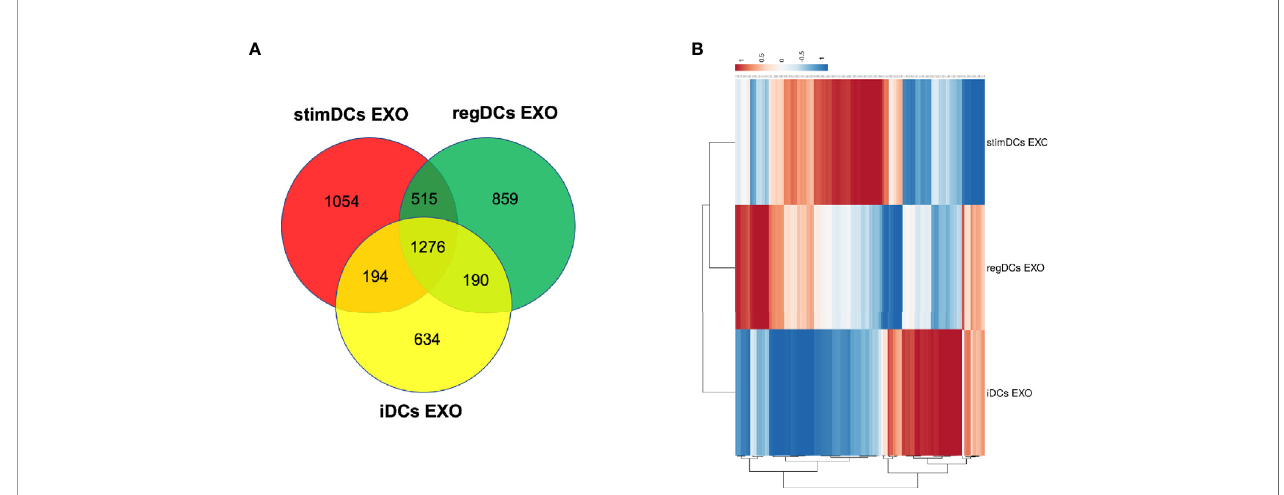
FIGURE 2 | (A) Venn diagram showing the overlap of proteins between regDCs EXO, iDCs EXO and StimDCs EXO. 1278 proteins were overlapped, whereas 859, 1,054, and 634 proteins were unique to regDCs EXO, stimDCs EXO, and iDCs EXO, respectively. (B) Heat map showing differential expression in the overlapped proteins. The dots are color coded with red and blue indicating upregulation and downregulation,